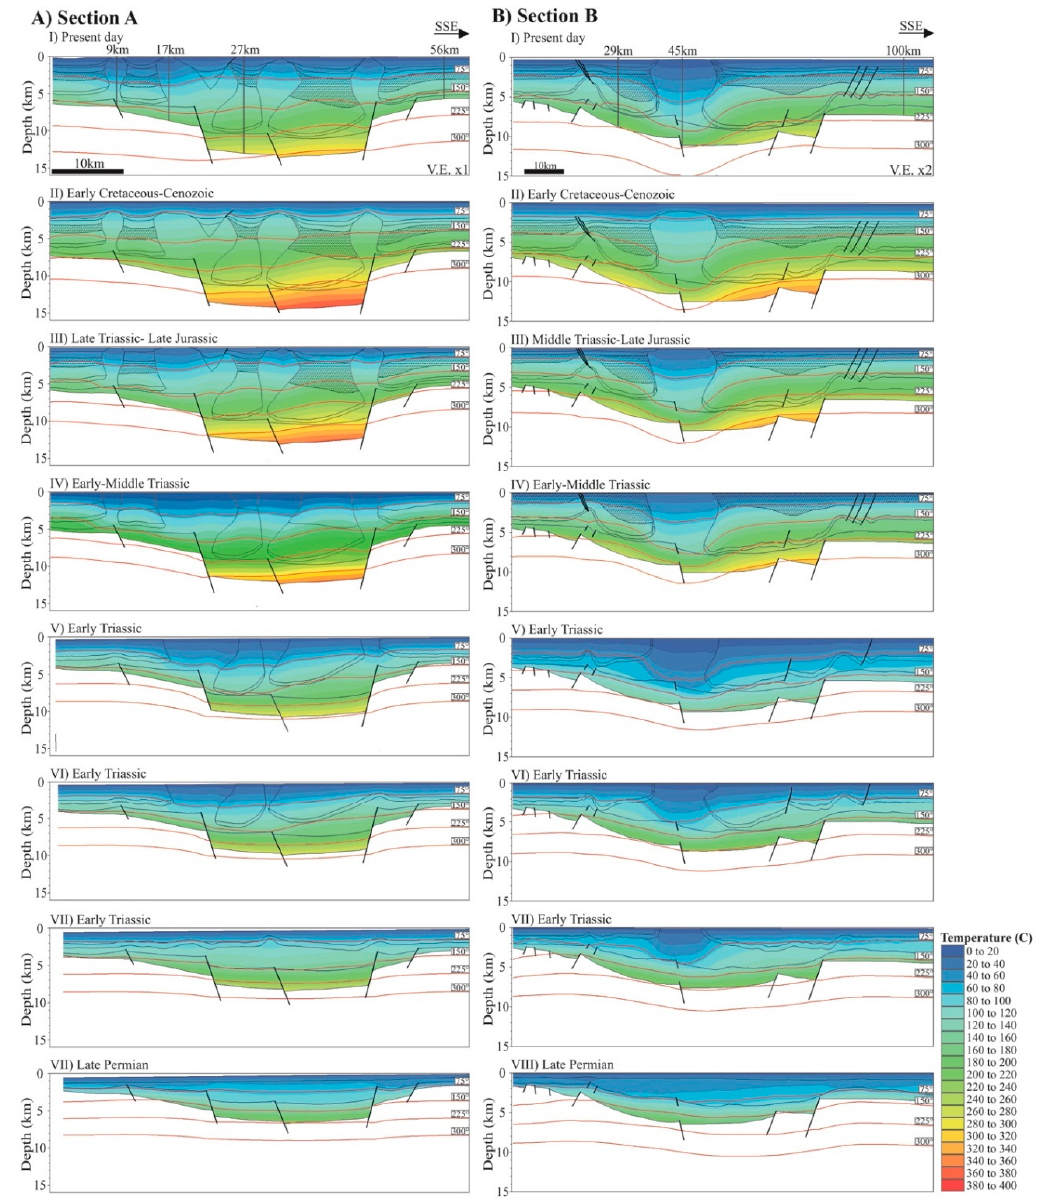
Figure 7. Evolution of temperature through time in ( A ) section A in the central sub-basin, and ( B ) section B in the eastern sub-basin. Black lines are unit contacts and red lines are isotherms. For guidance, stippled unit is the Lower to Middle Triassic Kobbe Formation (S4). Figure 1B shows the location of the sections.